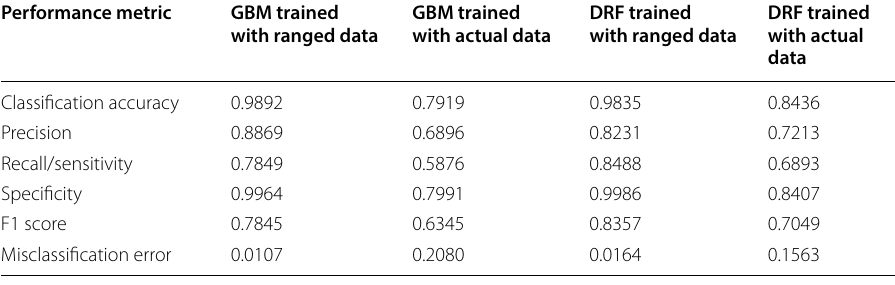
Table 6 Models’ characteristics during the testing phase Performance metric